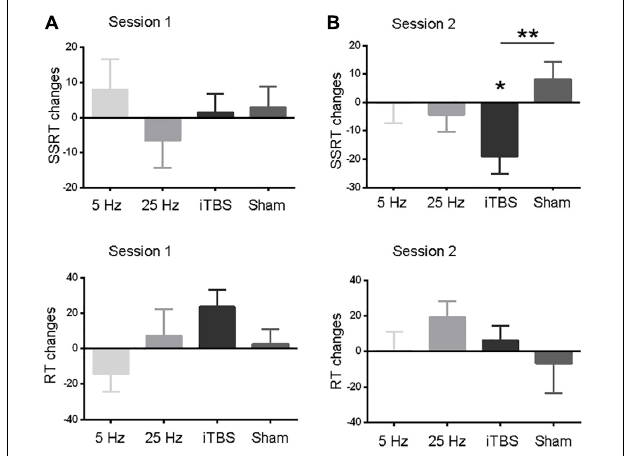
FIGURE 2 | Comparisons of behavior measures within and between protocols in sessions 1 (A) and 2 (B) . RT and SSRT changes ( Y axis) were computed by subtracting pre-rTMS from post-rTMS values. Data are shown as the mean and SEM. Asterisks indicate a significant within-protocol aftereffect. ∗ P < 0.05, ∗∗ P <